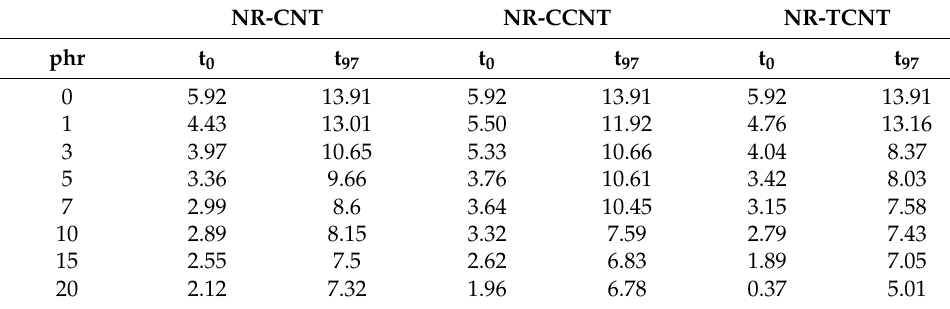
Figure 9. Rheometer curves of ( a ) NR/CNTs, ( b ) NR/CCNTs, and ( c ) NR/TCNTs composites. Table 4. Induction and vulcanization time of the studied compounds.